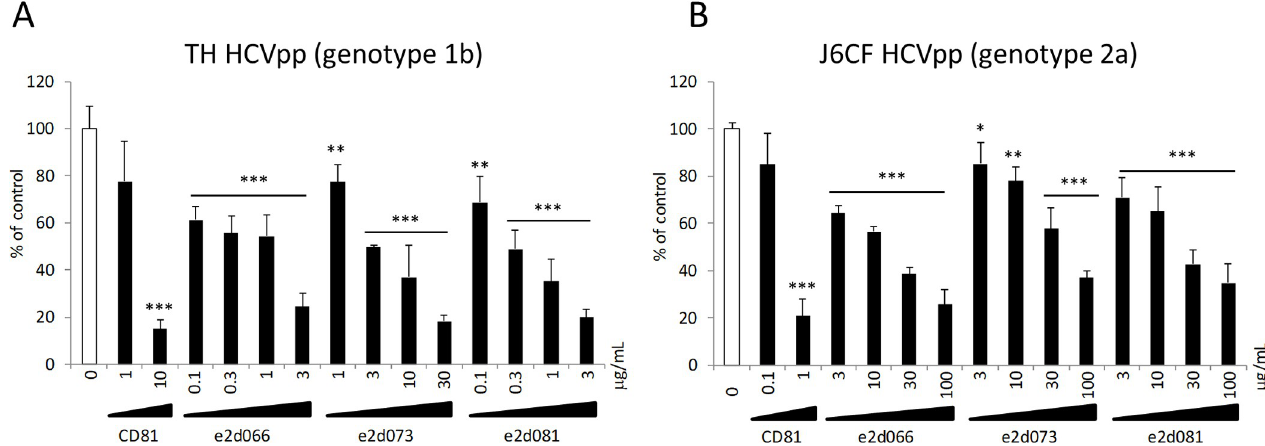
Fig 1. Neutralizing activities of phage library-derived IgGs against HCVpp infection. The neutralization effects of the e2d066, e2d073, and e2d081 antibodies were assessed by infection assays using HCV pseudoparticles (HCVpp) harboring the E1 and E2 glycoproteins of (A) TH (genotype 1b) and (B) J6CF (genotype 2a). HCVpp, which include a luciferase-encoding construct, were mixed with immunoglobulin G (IgG) or phosphate buffered saline (PBS) for 30 minutes at room temperature; the mixtures then were used to inoculate na ï ve Huh-7.5.1 cells. Monoclonal anti-CD81 antibody (JS-81, BD Pharmingen) was used as positive control in this assay. At 72 hours after infection, the infected cells were harvested and lysed with Cell Culture Lysis Reagent (Promega). Luciferase activity was quantified using the Luciferase Assay System (Promega). Neutralizing activity was calculated and is presented as the % neutralization by comparison with the luciferase activities of the well inoculated with the HCVpp-PBS mixture. Assay were performed in triplicate and infection rate are expressed as mean ± SEM. Statistical significance of difference was analyzed using one-way ANOVA with a Williams’ test ( � P < 0.025, �� P < 0.005, ��� P < 0.0005 vs